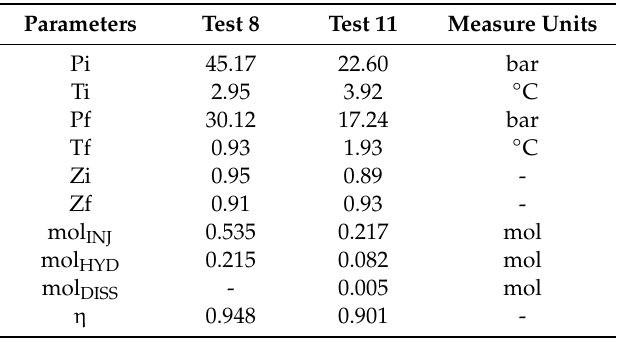
Table 5. Parameters related to Test 8 (with CH 4 ) and Test 11 (with CO 2